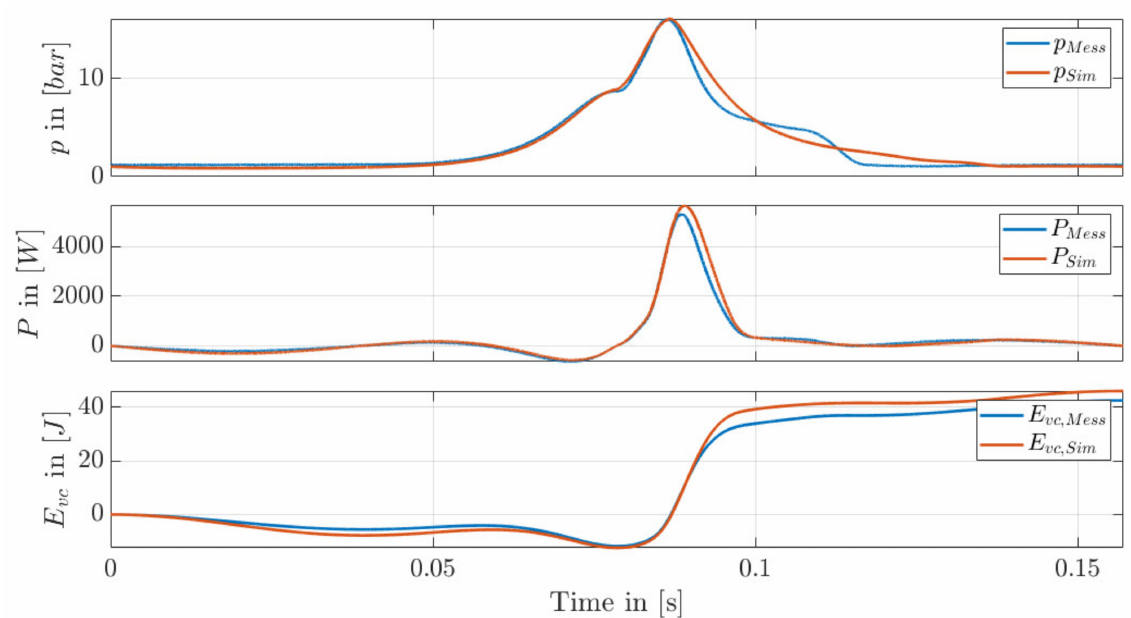
Figure 7. Comparison of the measured and simulated cylinder pressure, the engine power and the volume change energy.